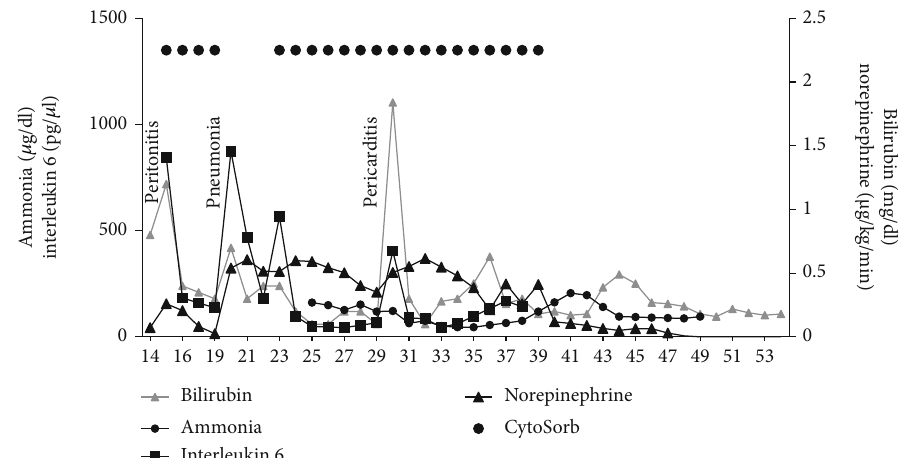
Figure 2: Ammonia, bilirubin, and interleukin 6 serum concentrations as well as norepinephrine dosage over time as well as hemoadsorption with CytoSorb ® starting on hospital day 15 and 22.